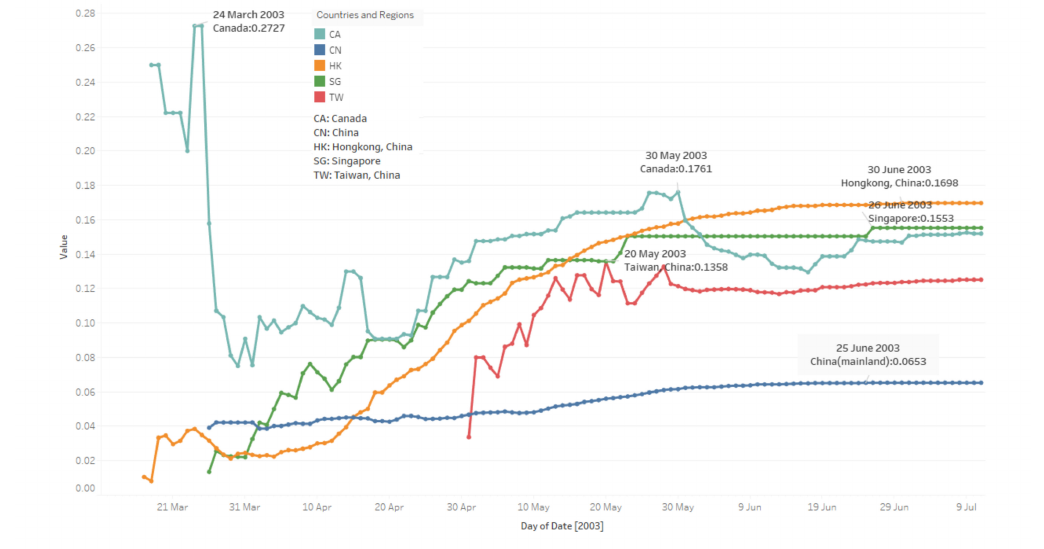
Figure 2. To-date mortality rate trends of five countries and regions. (17 March–11